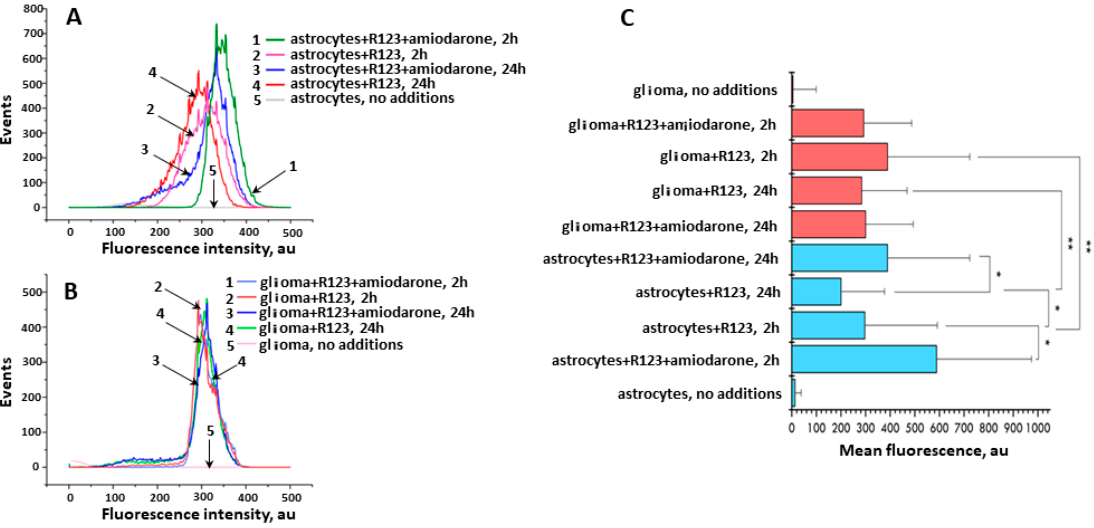
Figure 6. The mean fluorescence intensity measured by flow cytometry in astrocytes and glioma cells incubated with Rh123 (2 µM). ( A ) Distribution of fluorescence in astrocyte cells depending on the agents added to the incubation medium and incubation time; 1, green, astrocytes with Rh123 and amiodarone (2 µM) incubated for 2 h; 2, pink, astrocytes incubated with Rh123 for 2 h; 3, blue, as in 1 but incubated for 24 h; 4, red as in 2 but incubated for 24 h; 5, astrocytes, no additions; ( B ) Distribution of fluorescence in glioma cells depending on the added agents and incubation time; 1, light blue, glioma cells incubated with rhodamine 123 and amiodarone for 2 h; 2, red, as in 1 but without amiodarone; 3, dark blue, as in 1 but incubated for 24 h; 4, green, as in 2 but incubated for 24 h; 5, pink, glioma cell, no additions; ( C ) Median fluorescence of Rh123 in astrocyte and glioma cells treated with Rh123 and amiodarone (2 µM) for 2 or 24 h. * p < 0.05 according to the Wilcoxon